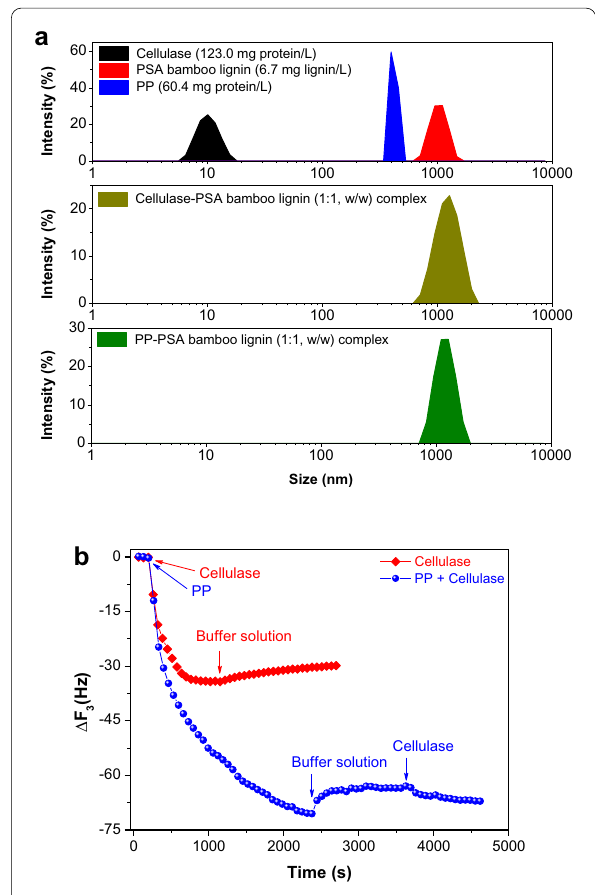
Fig. 5 a Particle size distributions of cellulase, PP, and PSA supernatants as well as their complexes; b adsorption/desorption behaviors of PP and enzymes on the lignin